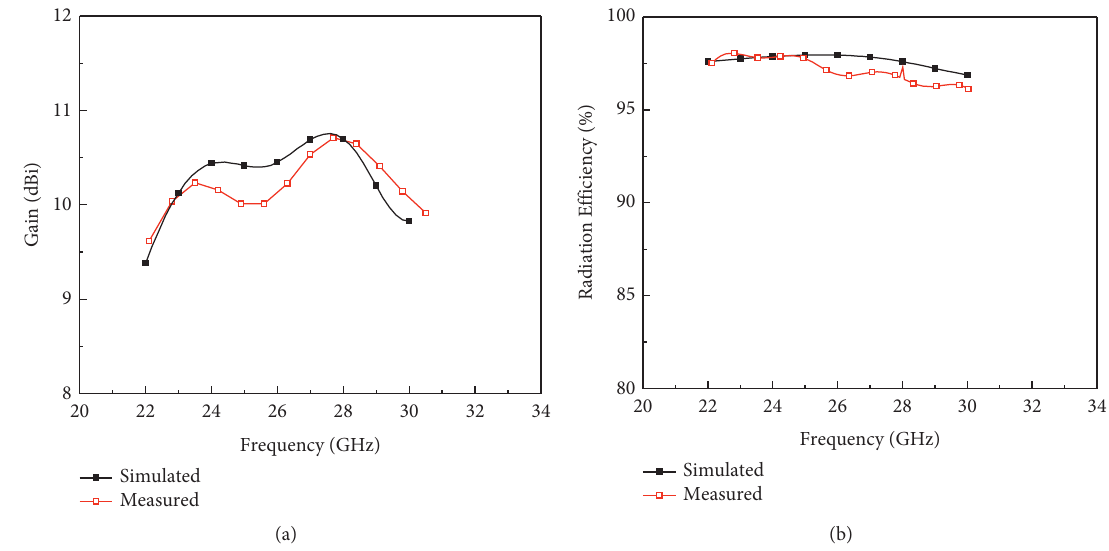
Figure 9: Simulated and measured (a) gain and (b) radiation efficiency of the proposed array.